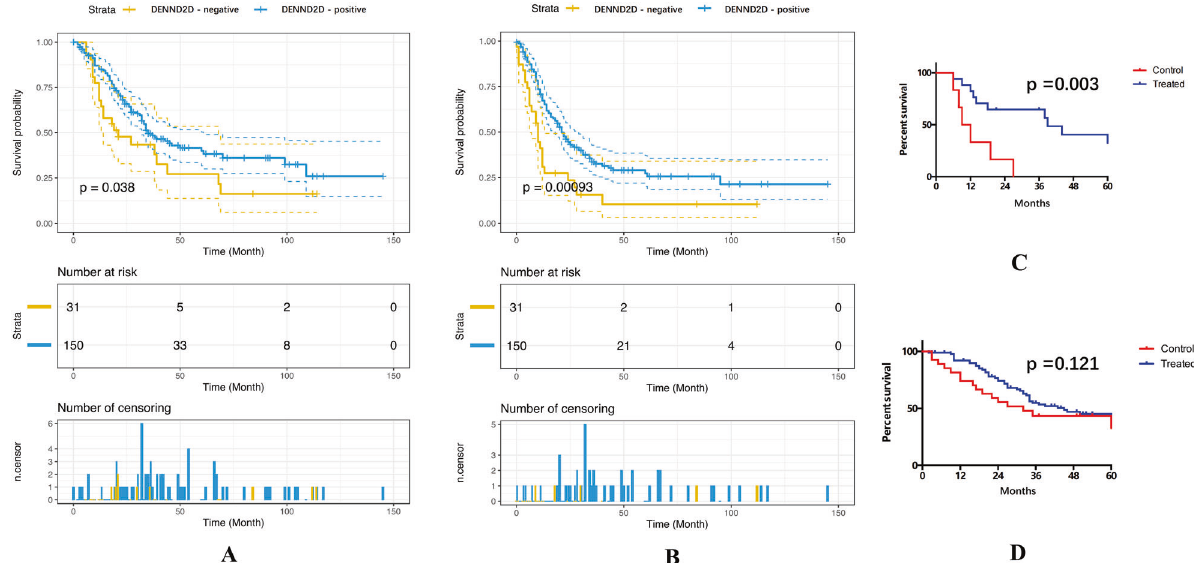
Fig. 2 DENND2D-negative patients with R0 resction bene fi t more from neoadjuvant chemotherapy. A Overall survival of 181 stage IV colon cancer patients with 95% con fi dence intervals. B Disease-free survival of 181 stage IV colon cancer patients with 95% con fi dence intervals. C Comparison of the survival rate between patients who had received R0 resection with or without neoadjuvant chemotherapy in the DENND2D-negative group. D Comparison of the survival rate between patients who had received R0 resection with or without neoadjuvant chemotherapy in the DENND2D-positive